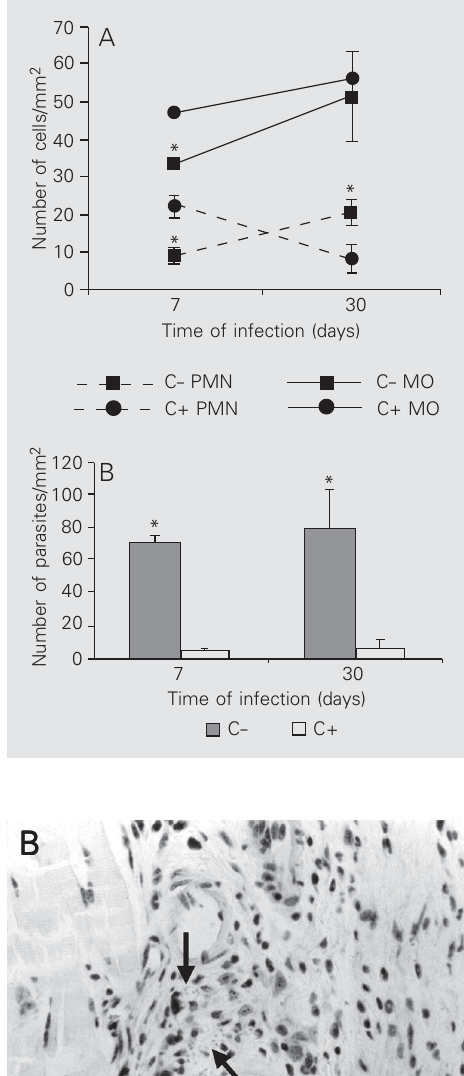
Figure 3. Histopathology of an Leishmania ( L. ) amazonensis subcutaneous inoculation site at 7 days post-infection (H&E, magnification 40X). A , Comple- ment-depleted mice showing high number of parasites sorounded by inflammatory cells (arrow). B , Non-depleted mice showing few parasites in the dermal inflammatory reac- tion (arrows). Bars = 50